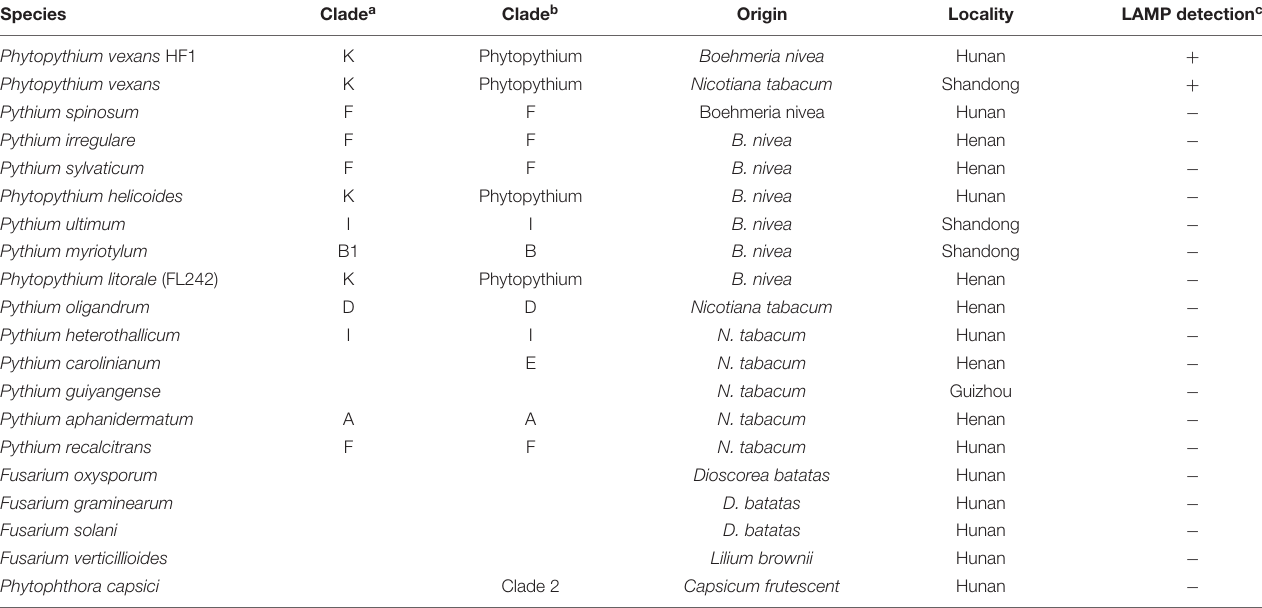
TABLE 1 | Isolates used to test the specificity of the loop-mediated isothermal amplification (LAMP) method and the assay results. Species Clade